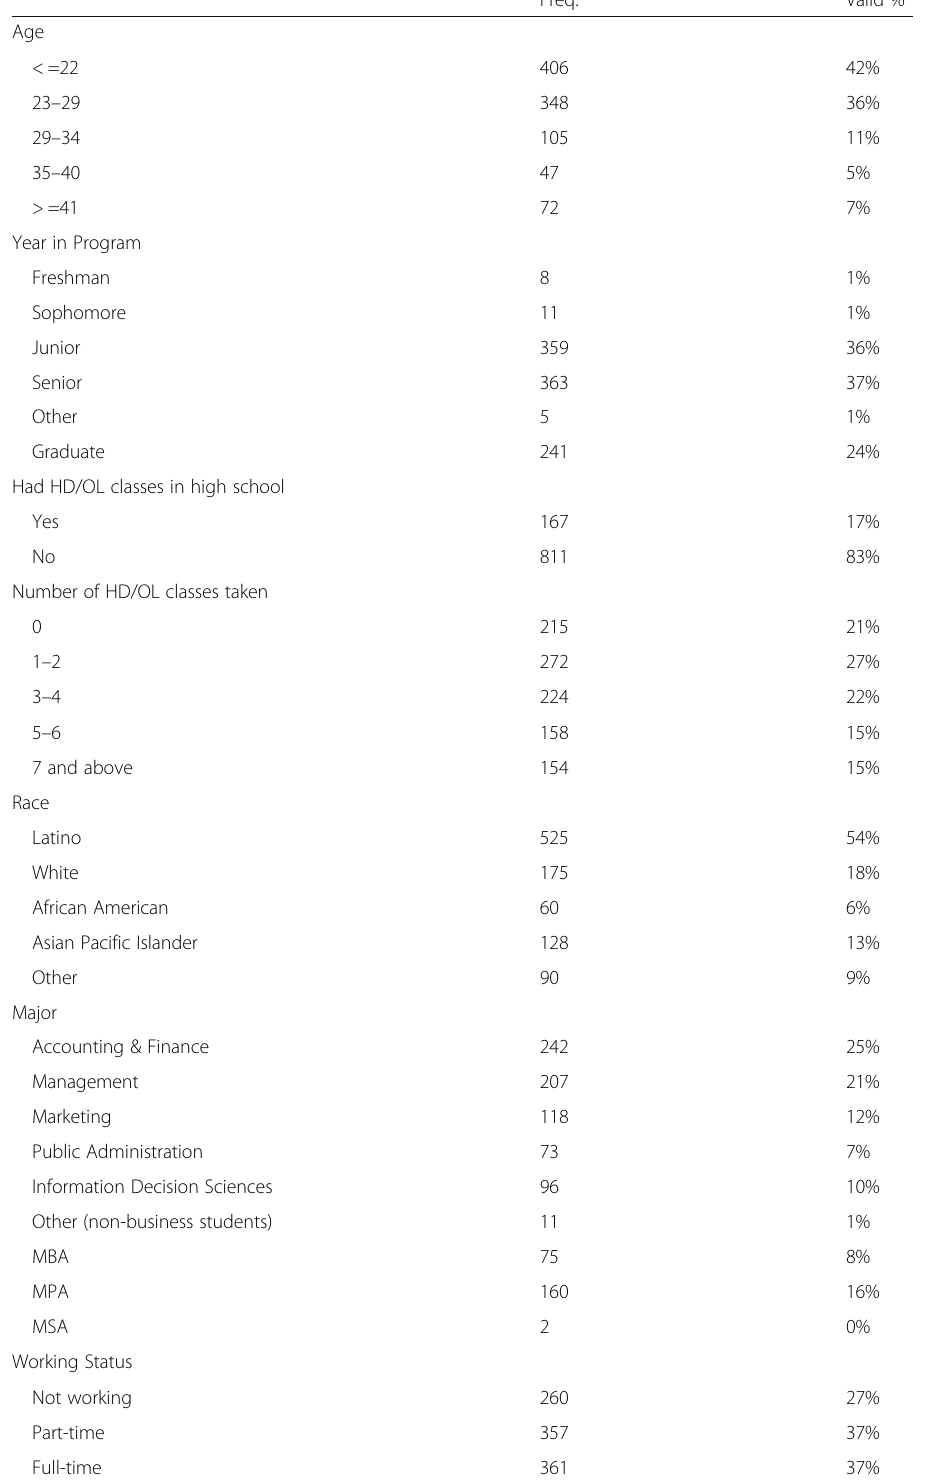
Table 1 Demographic Information of the Participants ( n = 987)